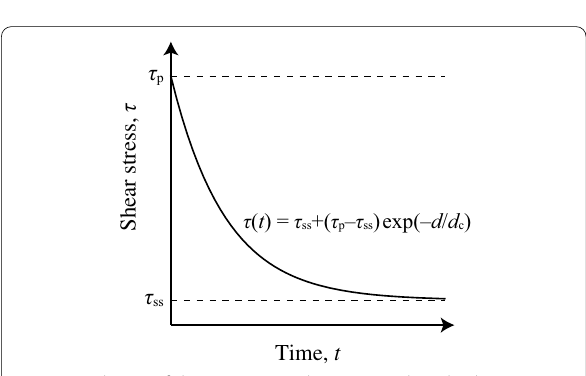
Fig. 2 Evolution of shear stress τ with time t , as described in Eq.